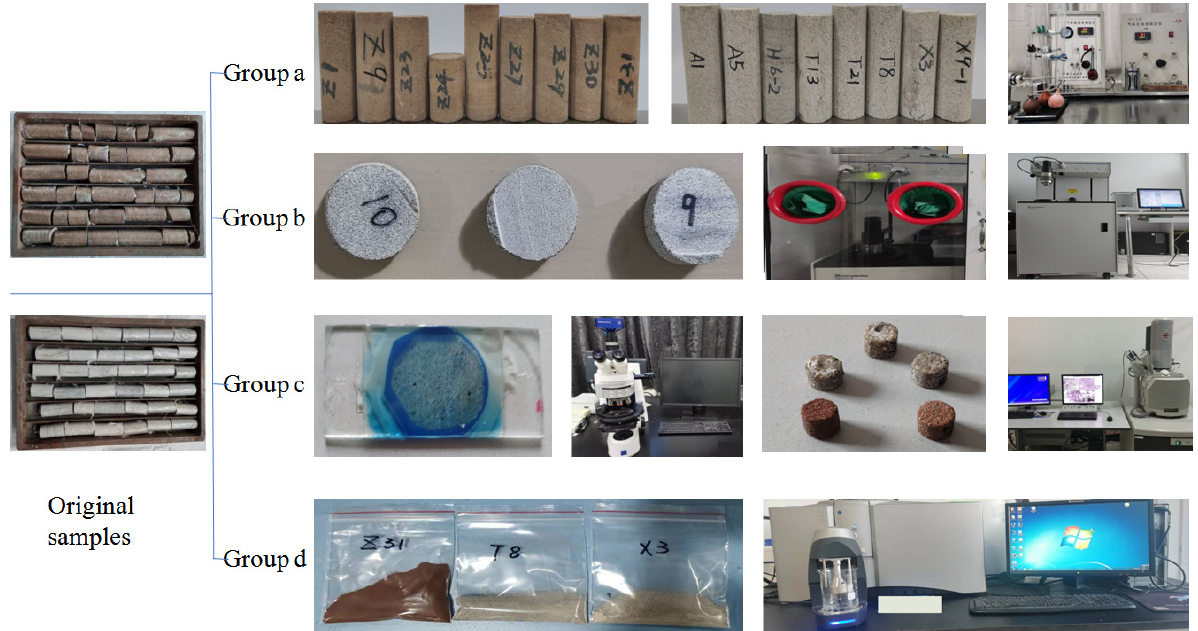
Figure 3. The original samples were divided into four groups to carry out various laboratory tests: ( a ) Standard plunger rock samples with a diameter of 25.4 mm and heights of 25.4–50.8 mm made by nondestructive wire cutting for porosity and permeability tests. ( b ) Samples with a height of 7.0–12.0 mm and diameter of 25.4 mm for mercury injection testing. ( c ) Casting thin slices for Zeiss Imaging-2M polarizing microscope observation; Samples with a height of 6.0 mm and diameter of 4.0 mm for SEM observation. ( d ) Samples by crushing, grinding, removing cement with hydrochloric acid and drying for grain size analysis.